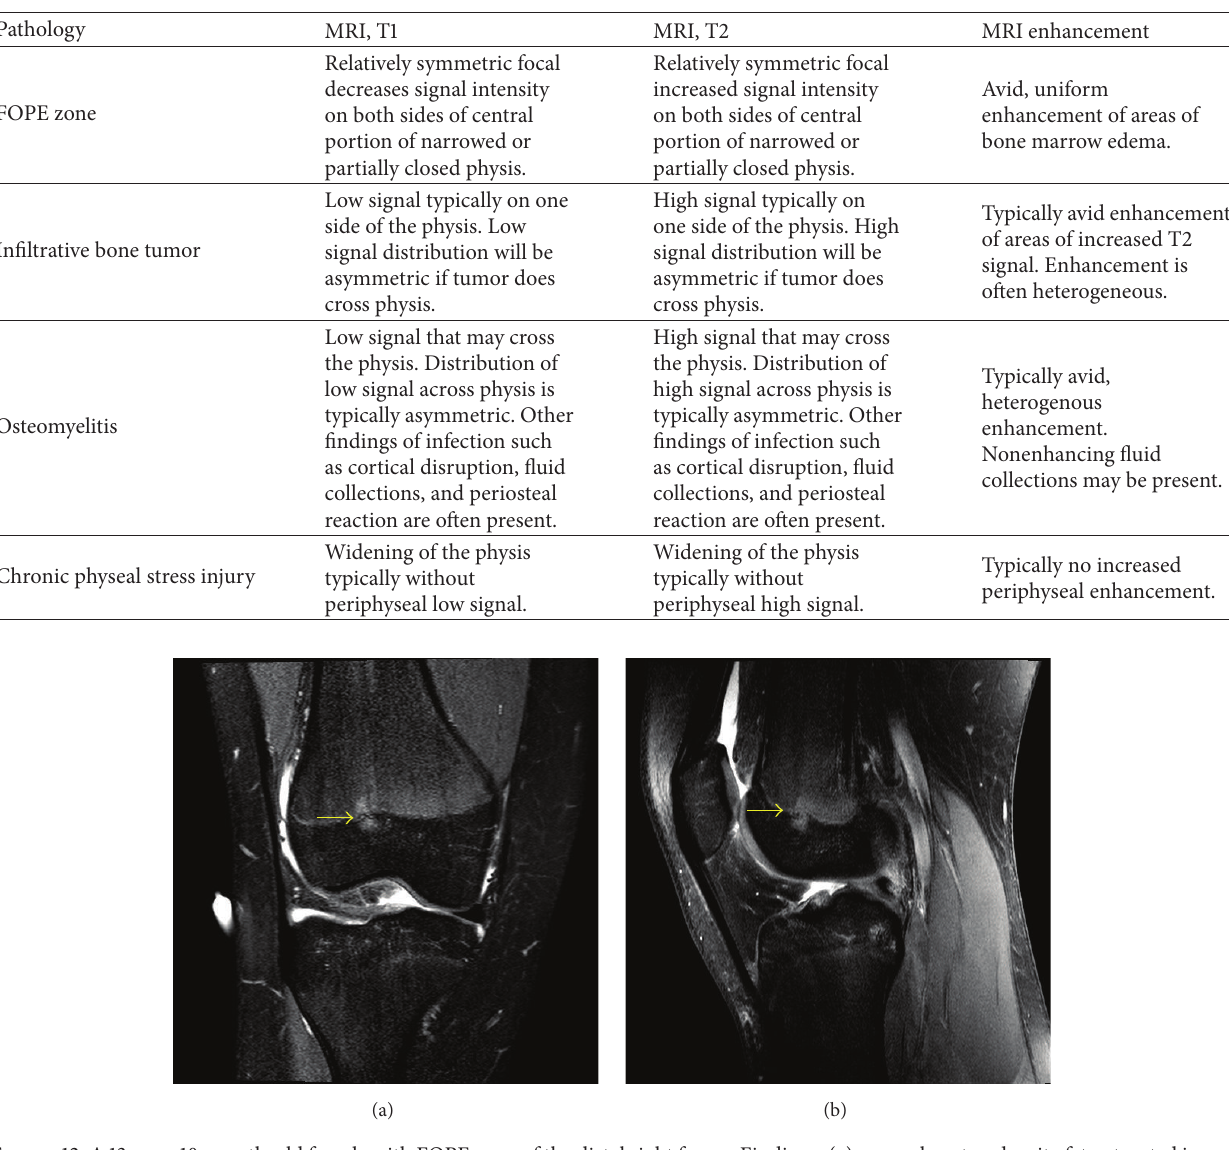
Figure 12: A 13-year-10-month-old female with FOPE zone of the distal right femur. Findings: (a) coronal proton density fat-saturated image shows a 5 mm area of periphyseal edema slightly eccentrically located on both sides of the distal femur physis (arrow). The edema is slightly more prominent on the epiphyseal side of the physis. (b) Sagittal proton density fat-saturated image again shows the eccentrically located area of periphyseal edema in the distal femur physis (arrow) with the edema again slightly more prominent on the epiphyseal side. The distal femur physis is narrowed but remains open. Technique: (a) coronal PD fat-saturated MRI (TR = 2,826.1, TE = 30), ST = 2.5 mm, spacing = 3.3 mm, FOV = 15cm, and matrix = 312 × 244; (b) coronal PD fat-saturated MRI (TR = 2,826.1, TE = 30), ST = 2.5 mm, spacing = 3.3 mm, FOV = 15cm, and matrix = 312 ×